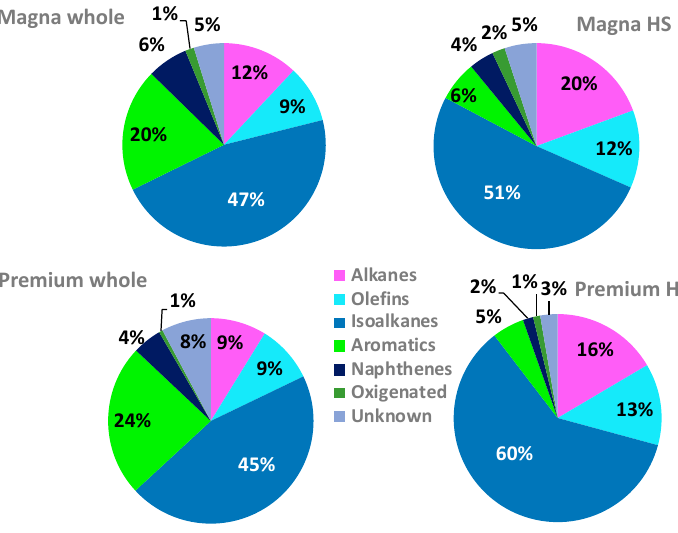
Figure 4. General composition of whole and head space Magna and Premium gasoline v / v %.